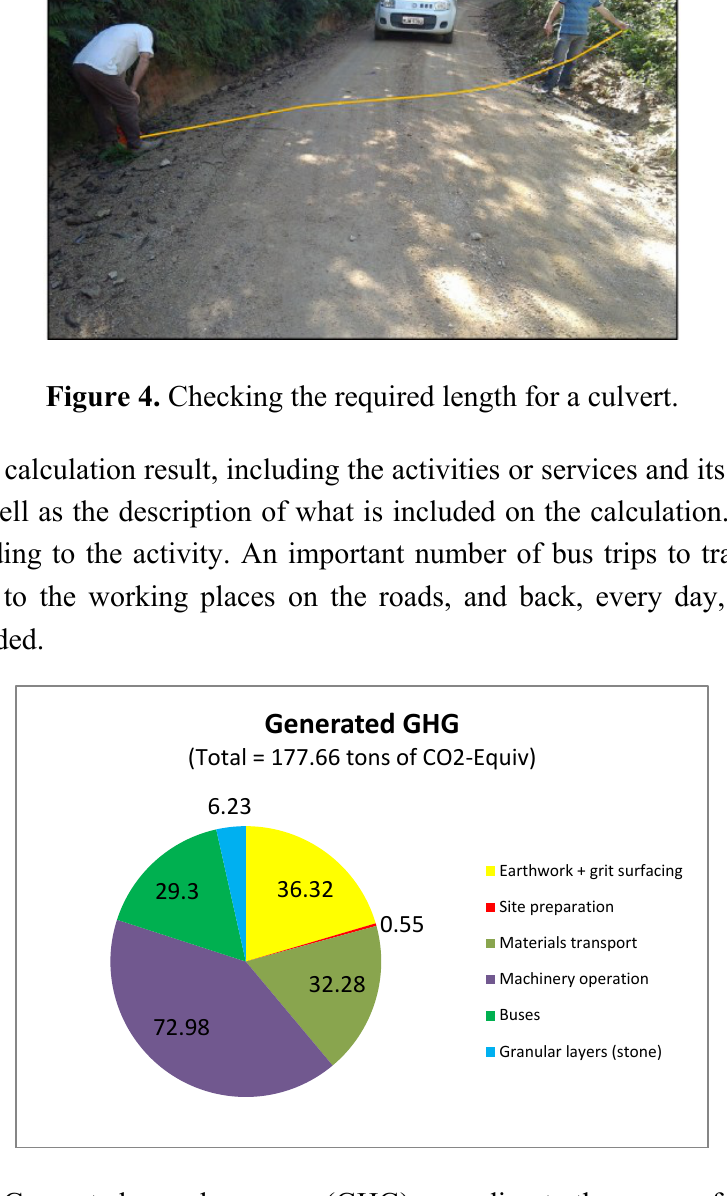
Figure 5. Generated greenhouse gas (GHG) according to the group of